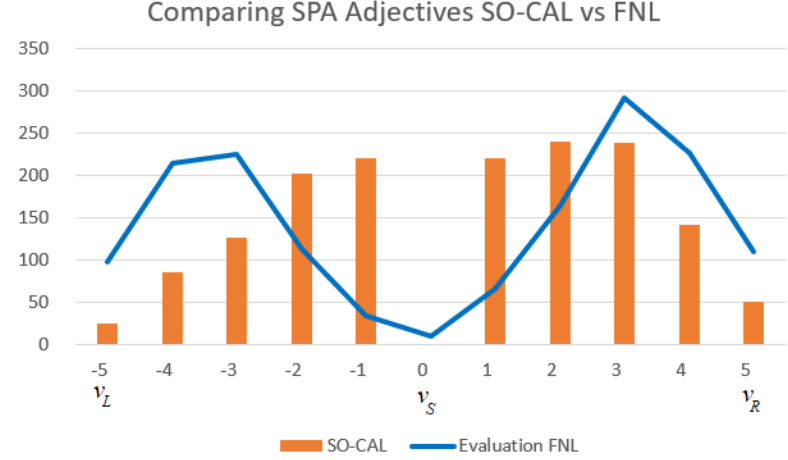
Figure 8. Spanish Adjectives SO-CAL vs. FNL